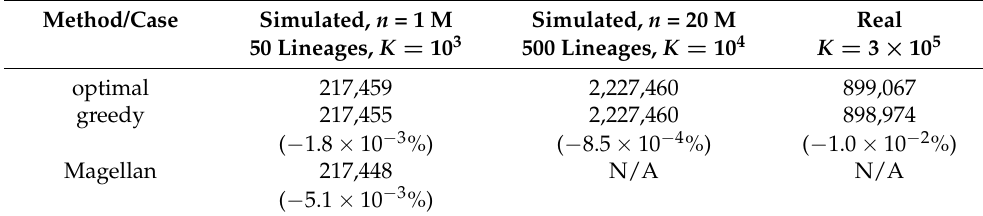
Table 2. Quality scores for optimal and greedy methods, for three sample cases. The values in parenthesis are the differences from optimal results, given in percentages. Result for the method implemented in Magellan software is given only for the smallest sample, as that method is too slow for the larger pedigrees. Method/Case Simulated, n = 1 M Simulated, n = 20 M Real 50 Lineages, K = 10 3 500 Lineages, K = 10 4 K = 3 × 10 5 optimal 217,459 2,227,460 899,067 greedy 217,455 2,227,460 898,974 ( − 1.8 × 10 − 3 %) ( − 8.5 × 10 − 4 %) ( − 1.0 × 10 − 2 %) Magellan 217,448 ( − 5.1 × 10 − 3